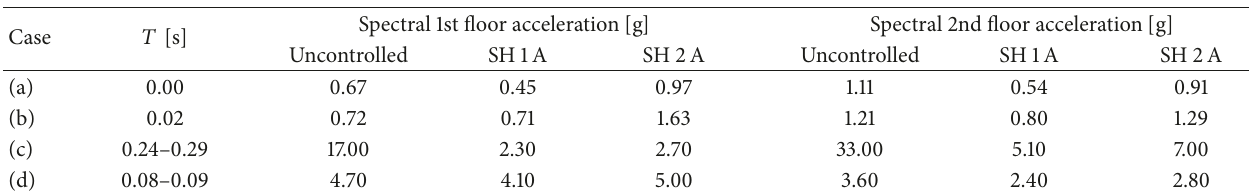
Figure 12: Response reduction in terms of interstory drifts for both SH1A and SH2A tests. Table 2: Floor spectral accelerations for selected periods of vibration of nonstructural components, corresponding to the cases of ( a ) a component firmly fixed to the slab, ( b ) a partition wall, and an element in resonance with the first ( c ) and the second ( d )